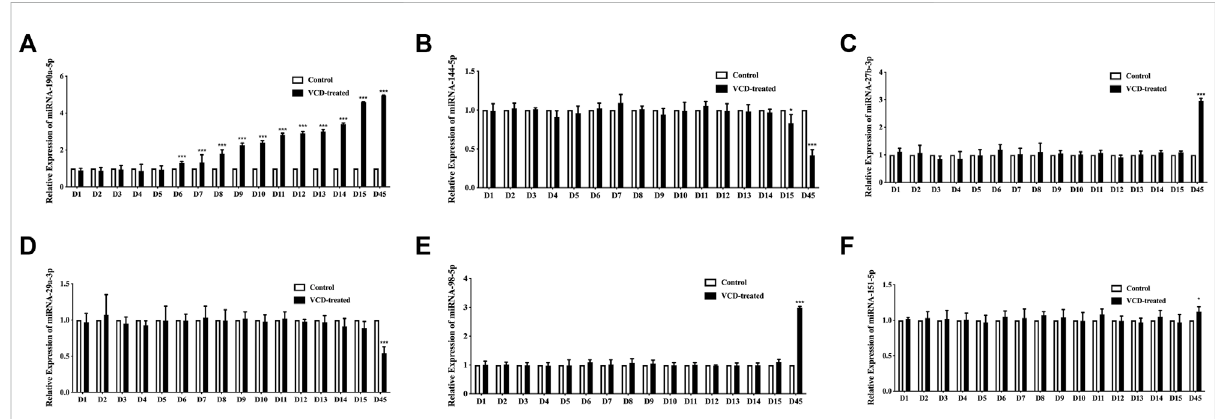
FIGURE 3 Screening of 6miRNAs for earlydifferential miRNAs intheVCDmodelingprocess. (A) miRNA-190a-5p, (B) miRNA-144-5p, (C) miRNA-27b-3p, (D) miRNA-29a-3p, (E) miRNA-98-5pand (F) miRNA-151-5p expressionlevels during VCD-treated process (D1-D15, D45) in rat ovaries tissues